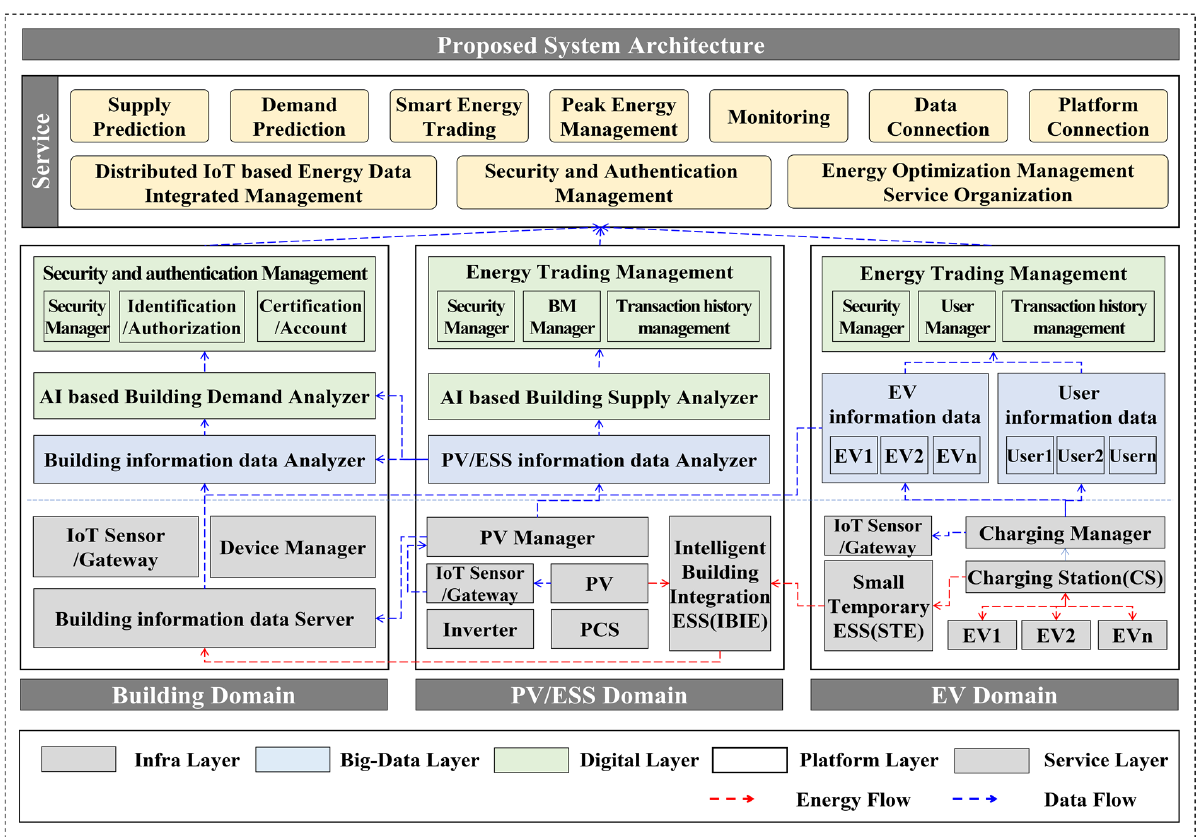
Figure 4. Proposed System Architecture.